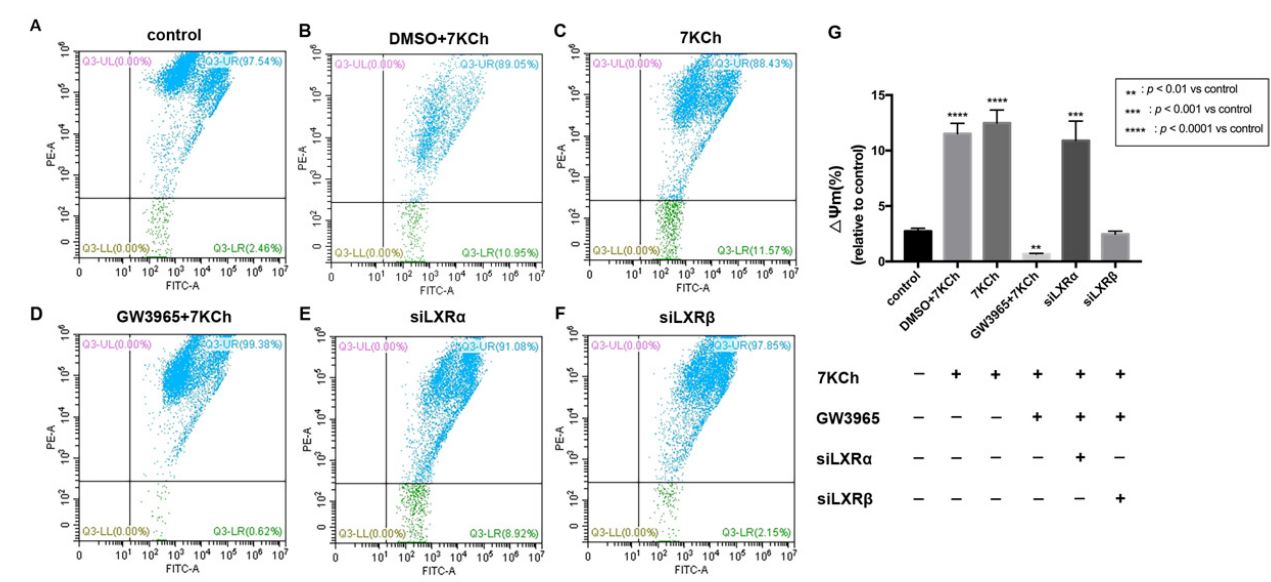
11 of 16 Figure 7. LXR activation in ARPE-19 cells. ( A ) LXR α expressions were detected by western blot and presented relative to controls. ( Β ) LXR β expressions were detected by western blot and presented relative to controls. Data are represented as mean ± SEM of three independent experiments. Differ- ences with p < 0.05 were considered statistically significant . 3.8. Flow Cytometric Analysis of Mitochondrial Membrane Potential in ARPE-19 Cells JC-1 detection of the mitochondrial membrane potential of ARPE-19 cells showed that apoptotic cells accounted for 2.46% of normal ARPE-19 cells (Figure 8A). After 7 KCh treatment, the percentage of apoptotic cells in the 7KCh group increased by 9.11% com- pared with that in the normal control group ( p < 0.0001) (Figure 8A,C). Following the treatment with GW3965 (2 μΜ ) and 7KCh (20 μ M), the percentage of apoptotic cells was 0.62%, which was 1.84% less than the normal control group ( p < 0.05) (Figure 8A,D).